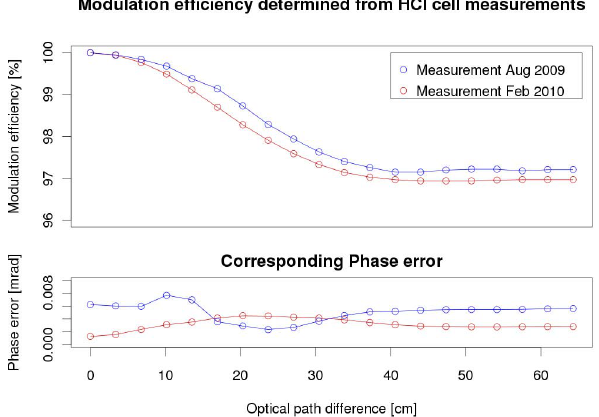
Fig. 11. Changes in the modulation efficiency and phase error of the Jena BRUKER IFS125HR from August 2009 to February